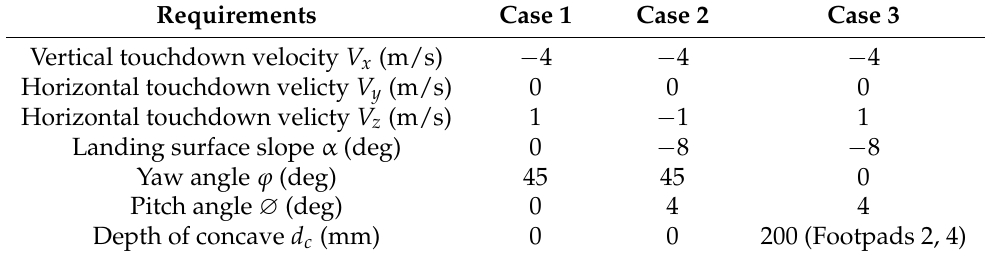
Table 6. Landing